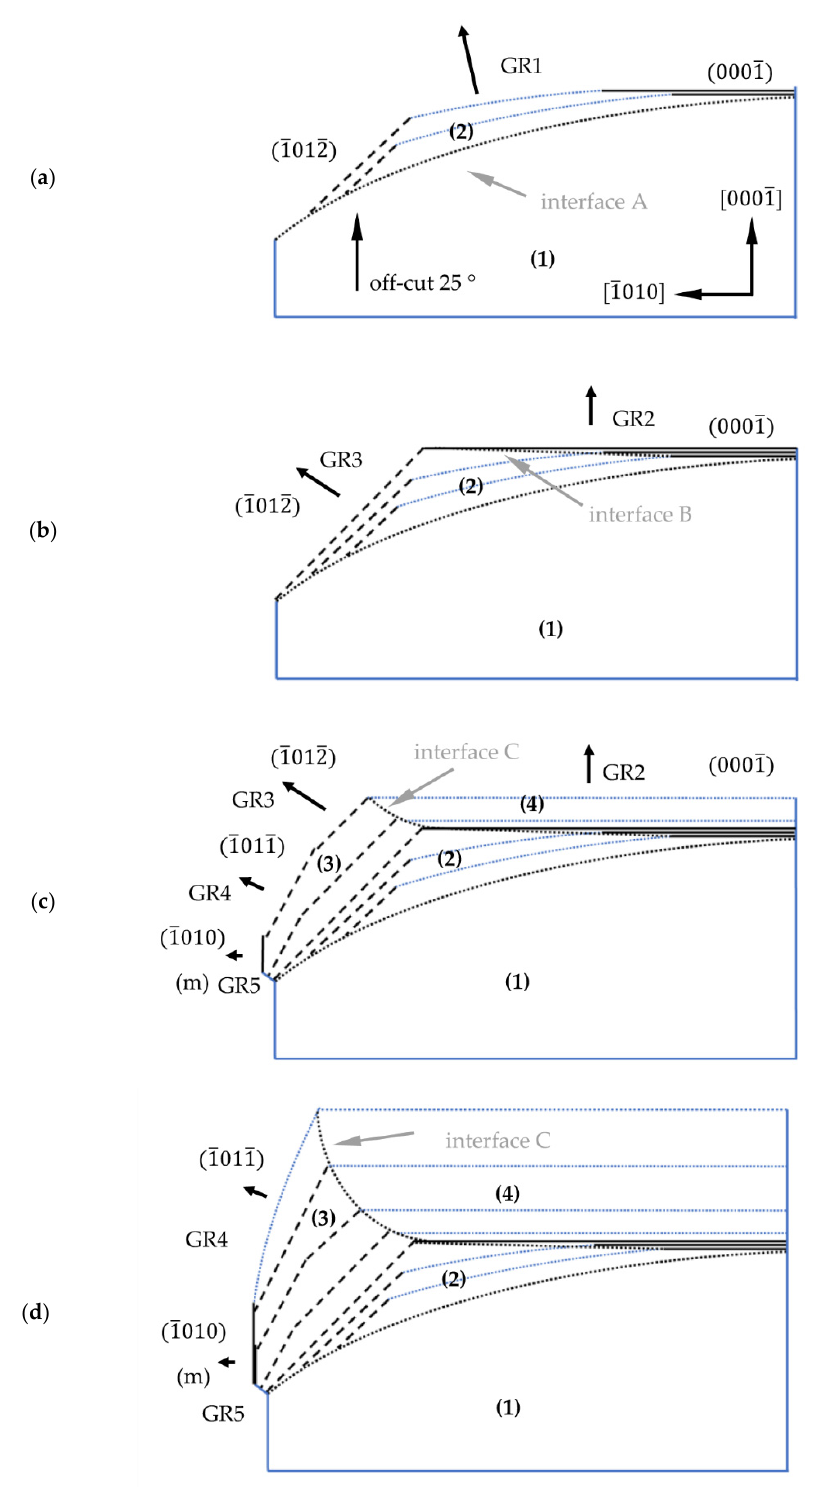
(cid:2) (cid:3) (cid:2) (cid:3) Figure 11. Model of Am-GaN growth on a lenticular seed along the 0001 and 1010 directions (cid:0) (cid:1) (cid:0) (cid:1) with a view of the 1210 plane: ( a ) the first stage of the growth—recovery of the 0001 plane and (cid:0) (cid:1) (cid:0) (cid:1) Figure 11. Model of Am-GaN growth on a lenticular seed along the [0001(cid:3364)] and [1(cid:3364)010] directions formation of the 1012 semi-polar plane; ( b ) growth on the recovered 0001 plane and growth on (cid:0) (cid:1) (cid:0) (cid:1) (cid:0) (cid:1) (cid:0) (cid:1) (cid:0) (cid:1) with a view of the (12(cid:3364)10) plane: ( a ) the first stage of the growth—recovery of the (0001(cid:3364)) plane the 1012 plane; ( c ) growth on the 0001 , 1012 , 1011 and 1010 planes; ( d ) expansion of the and formation of the (1(cid:3364)012(cid:3364)) semi-polar plane; ( b ) growth on the recovered (0001(cid:3364)) plane and (cid:0) (cid:1) (cid:0) (cid:1) (cid:0) (cid:1) 1010 plane and transition from growth of the 1012 to the 1011 growth on the (1(cid:3364)012(cid:3364)) plane; ( c ) growth on the (0001(cid:3364)) , (1(cid:3364)012(cid:3364)) , (1(cid:3364)011(cid:3364)) and (1(cid:3364)010) planes; ( d ) ex- pansion of the (1(cid:3364)010) plane and transition from growth of the (1(cid:3364)012(cid:3364)) to the (1(cid:3364)011(cid:3364)) plane. Figure 12 shows the sequence of the growth process from the perspective of the (1(cid:3364)100) plane. The crystal’s shape in the initial phase of the growth run is presented in Figure 12a. The crystallization started where interface A was marked and was carried out perpendicularly to this interface. A part of the crystal grown with the high rate GR1 led to the formation of two crystallographic planes. Above the center of the seed, where the off-cut was close to 0°, restoration of the stable (0001(cid:3364)) plane occurred. Near the edge of the seed, where the off-cut of the seed started to exceed 25°, the (1(cid:3364)1(cid:3364)24(cid:3364)) plane was devel- oped. Next, crystallization was carried out on three surfaces: parallel to the curvature of the seed (with the highest GR1), on the semi-polar (1(cid:3364)1(cid:3364)24(cid:3364)) plane (with lower GR2) and on the recovered (0001(cid:3364)) plane (the lowest GR3). ( a ) ( b )